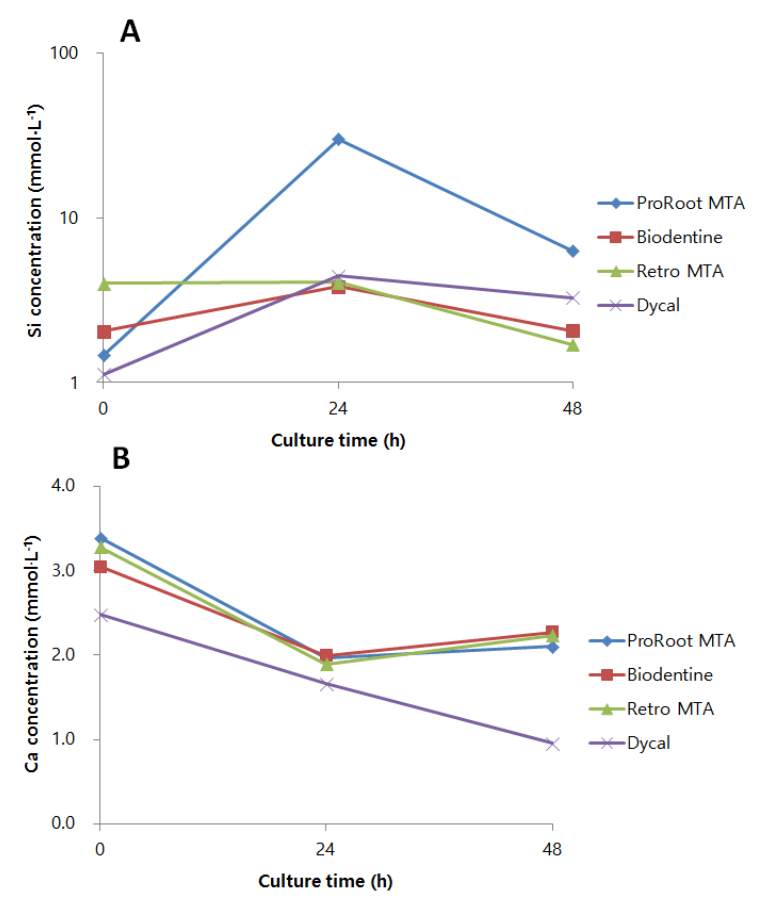
Figure 5. Ion concentrations from material extract medium evaluated by ICP-MS. ( A ) Si and ( B ) Ca ion concentrations of material extract-conditioned medium were measured up to 48 h. ProRoot MTA, LDPSCs cultured with ProRoot MTA extract medium; Biodentine, LDPSCs cultured with Biodentine extract medium; Retro MTA, LDPSCs cultured with Retro MTA extract medium; Dycal, LDPSCs cultured with Dycal extract medium.